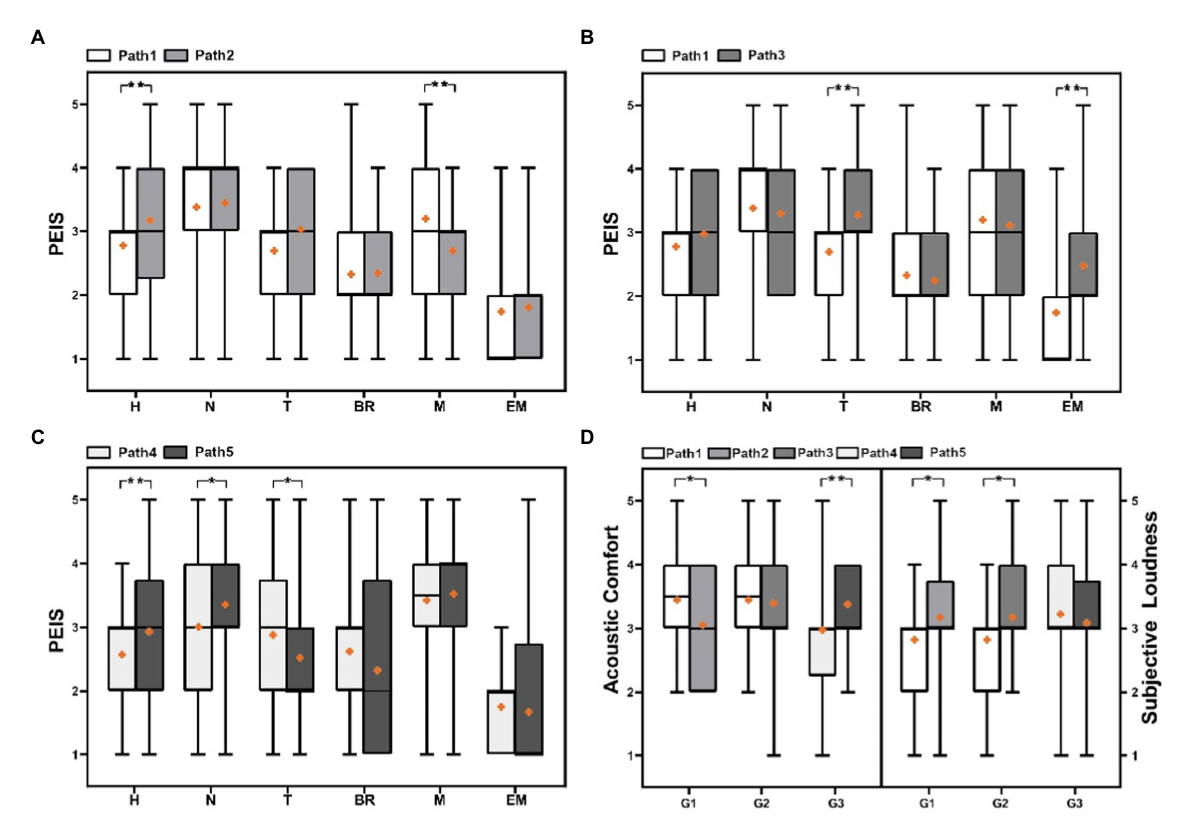
FIGURE 4 Comparison of the PEIS, acoustic comfort, and subjective loudness in different soundwalk paths: (A) PEIS in Path1 vs. Path 2, (B) PEIS in Path1 vs. Path 3, (C) PEIS in Path4 vs. Path 5, (D) Acoustic comfort and subjective loudness in G1, G2 and G3 (H, Human sound; N, Natural sound; T, Traffic noise; BR, Broadcast sound; M, Music; EM, Electro-mechanical sound. G1: Path 1 vs. Path 2, G2: Path 1 vs. Path 3 and G3: Path 4 vs. Path 5. * p < 0.05, ** p <